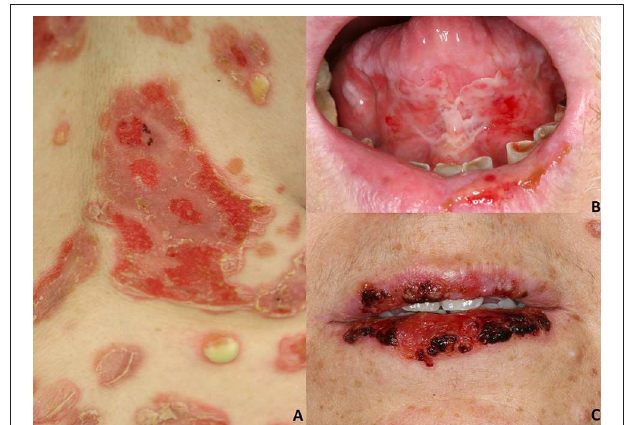
FIGURE 1 | Pemphigus vulgaris: (A) Flaccid cutaneous blisters associated with erosions; (B) Multiple erosions of the tongue and of the lips; Paraneoplastic pemphigus: (C) haemorrhagic crusts and erosion of the lips. All the patients gave written informed consent for the publication of the pictures.